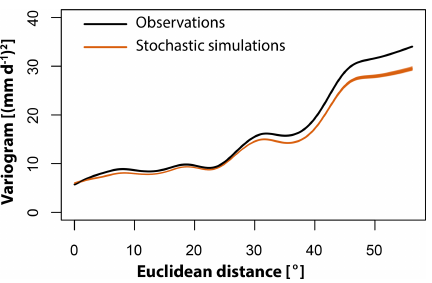
Figure 8. Comparison of observed variogram (black) with 100 var- iograms derived from the 100 simulation runs